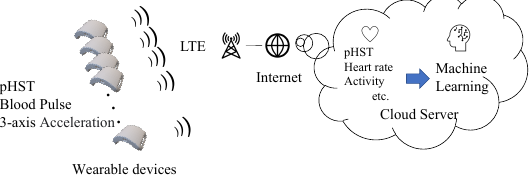
Figure 6. System development to collect vital sensing data. Table 1. Hardware